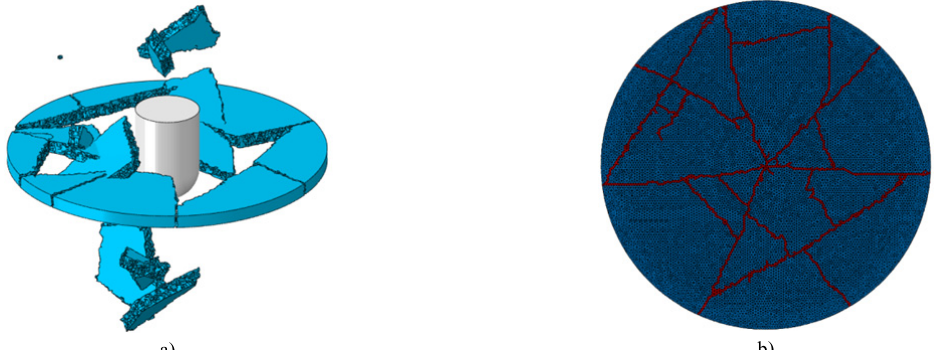
Fig. 16 Glass cracking and fragmentation at t = 10ms for drop weight impact simulation with immediate failure model; a) perspective view, b) bottom view of failed elements.